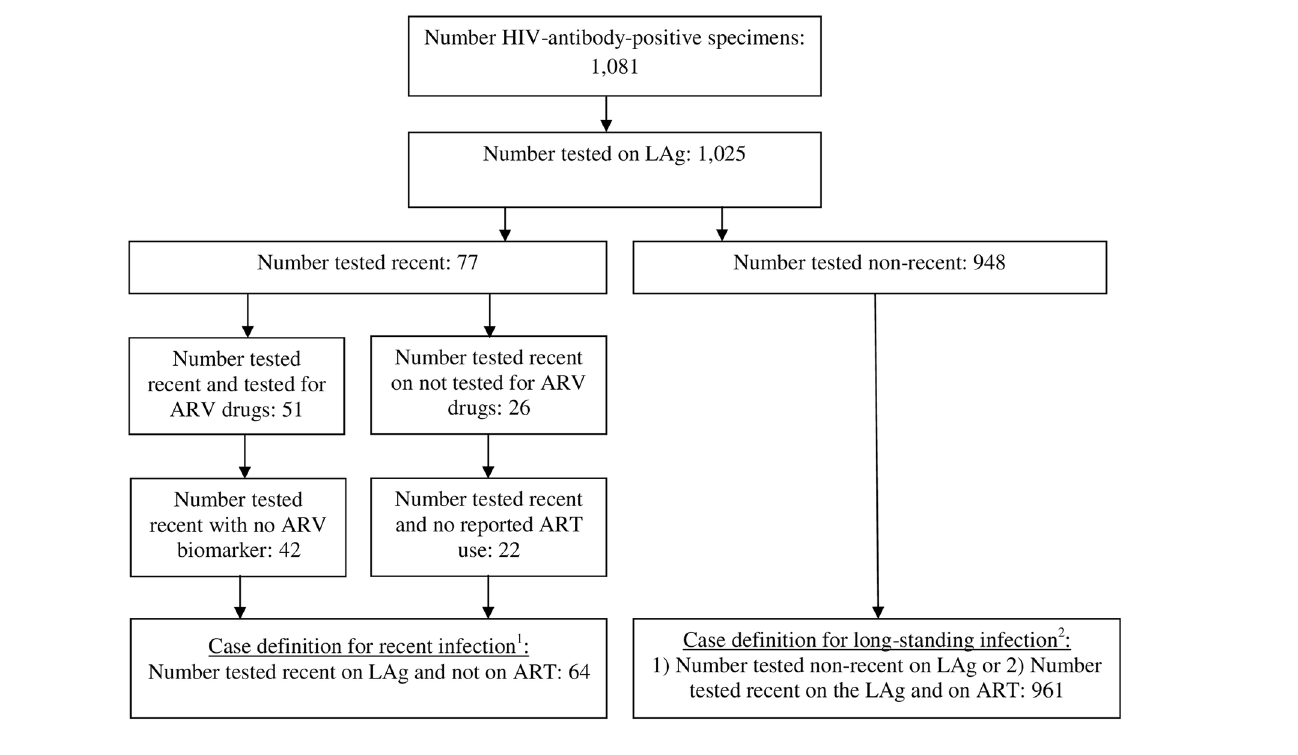
Fig 1. HIV-antibody-positive specimens in the 2007 Kenya AIDS Indicator